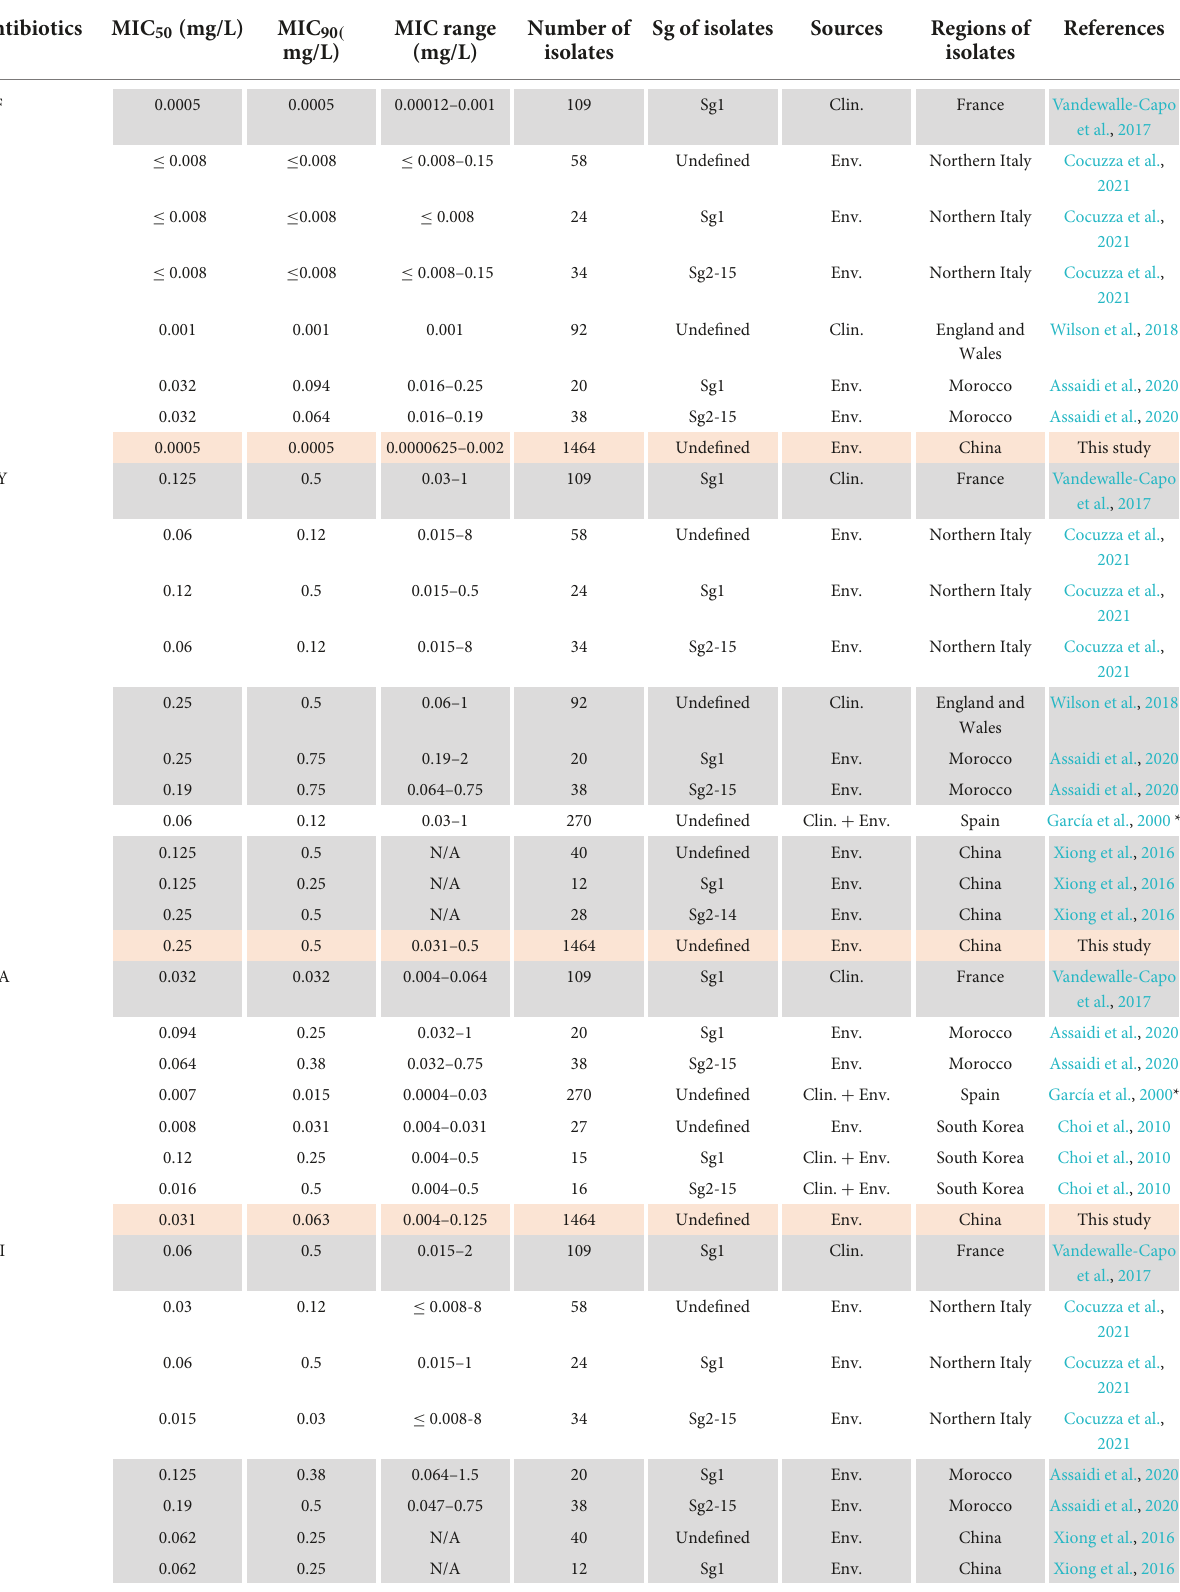
TABLE 2 Susceptibility of antimicrobials against Legionella pneumophila by the BMD method described by other articles.